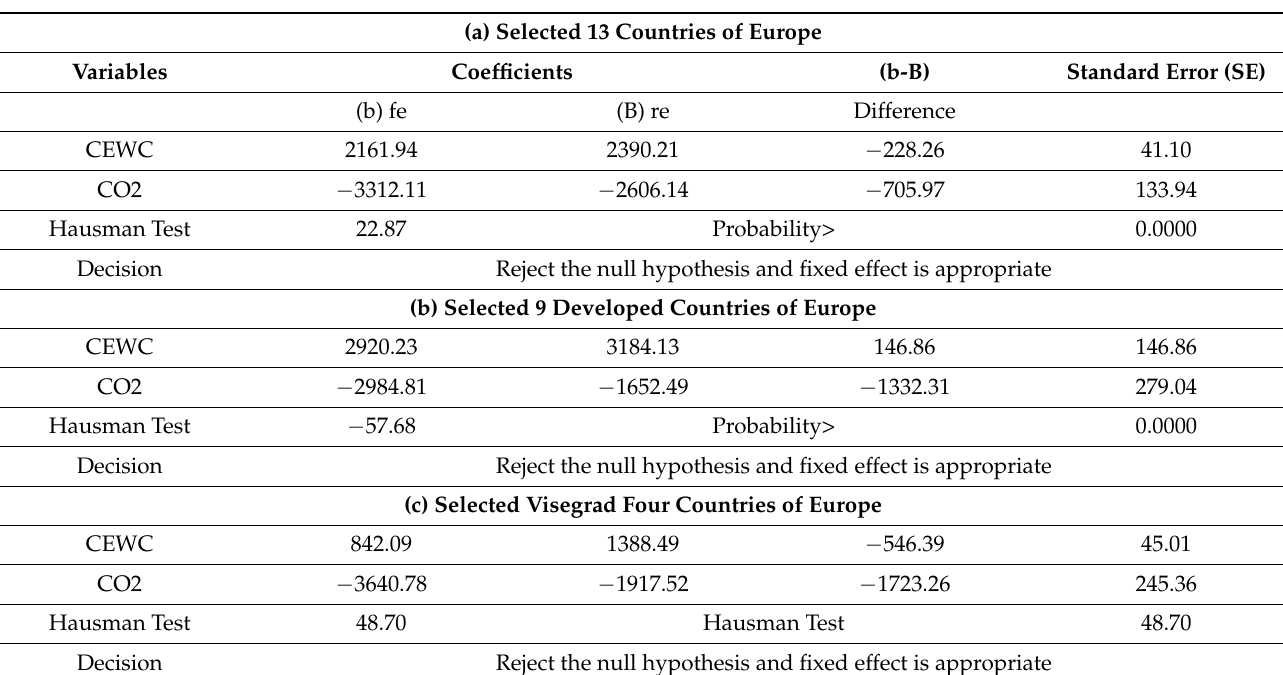
Table A2. Result of Hausman